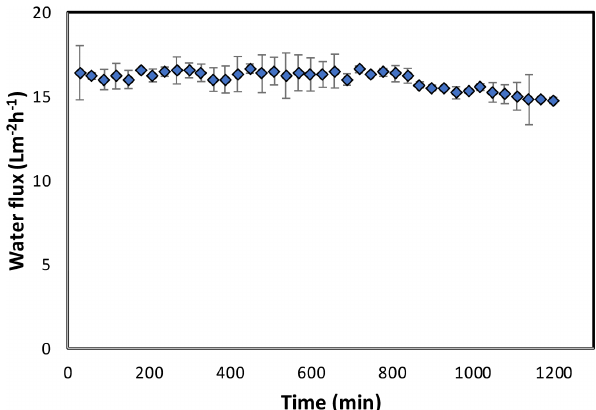
Figure 6. Stress and strain relationship of the PAN support layer. Figure 7. Forward osmosis water flux for the PAN-TFC mem- brane. Experimental conditions: feed solution: DI water, draw so- Table 1. Mechanical properties of the PAN support layer. lution: 1M NaCl, FO mode, volumetric flow rate of feed and draw 0.6Lmin − 1 , temp 25 ◦ C, zero transmembrane pressure. Results are Mechanical property Average Standard Units an average of three experiments with different coupons. Error bars value deviation indicate standard deviation. Young’s modulus 9.4065 1.0288 MPa Tensile strength 1.3586 0.1428 MPa Elongation at break 17.8463 3.5857 (%)